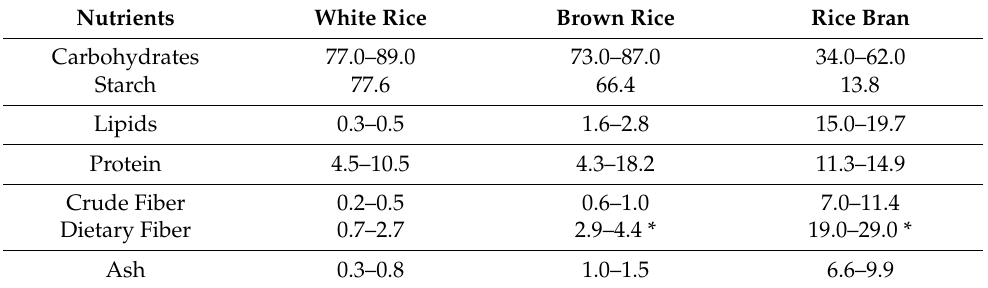
Table 1. Basic composition of white rice and rice bran (%) 1 .